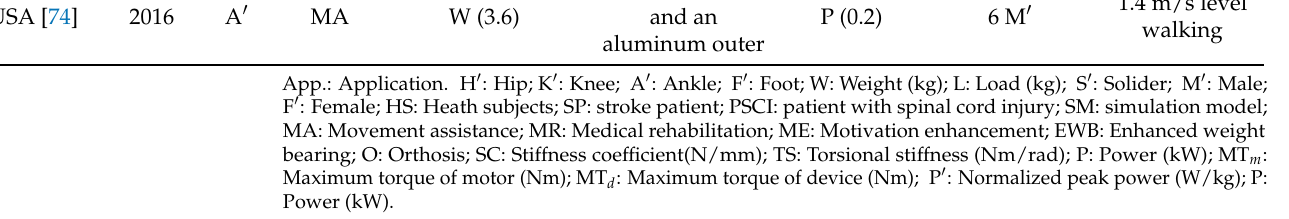
Table 4. Unpowered lower limb multi-joint assisted